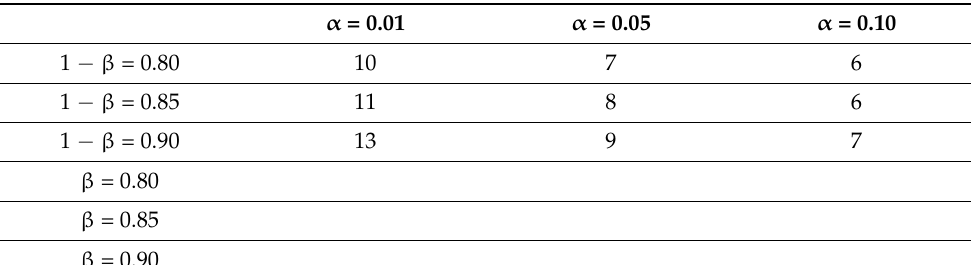
Table 1. Sample size values for each group. β : Power; α : Significance level. α =